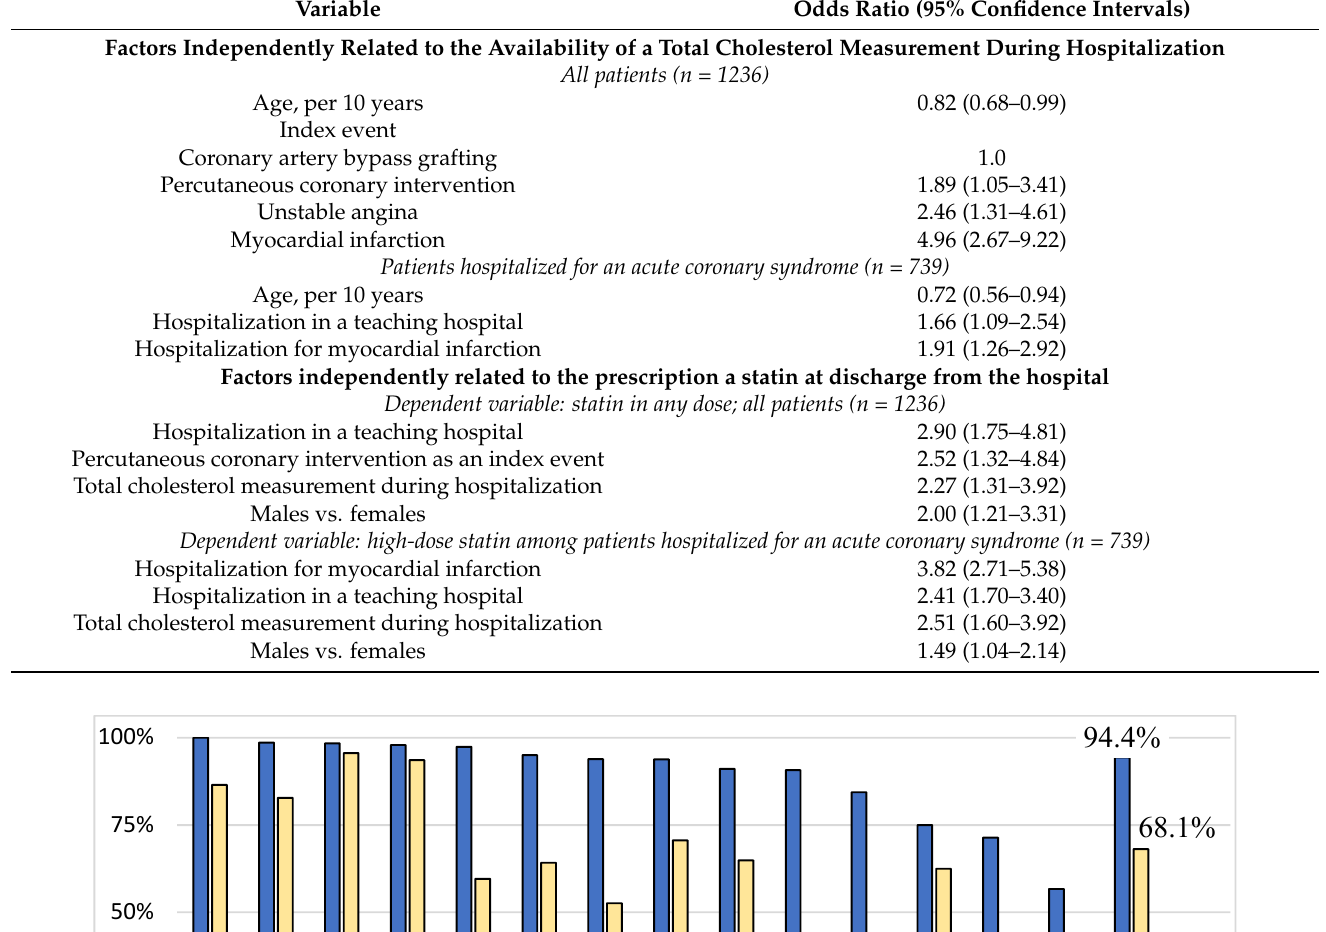
Table 2. Factors independently related to the availability of a total cholesterol measurement during hospitalization and to the prescription of a statin at discharge from the hospital.